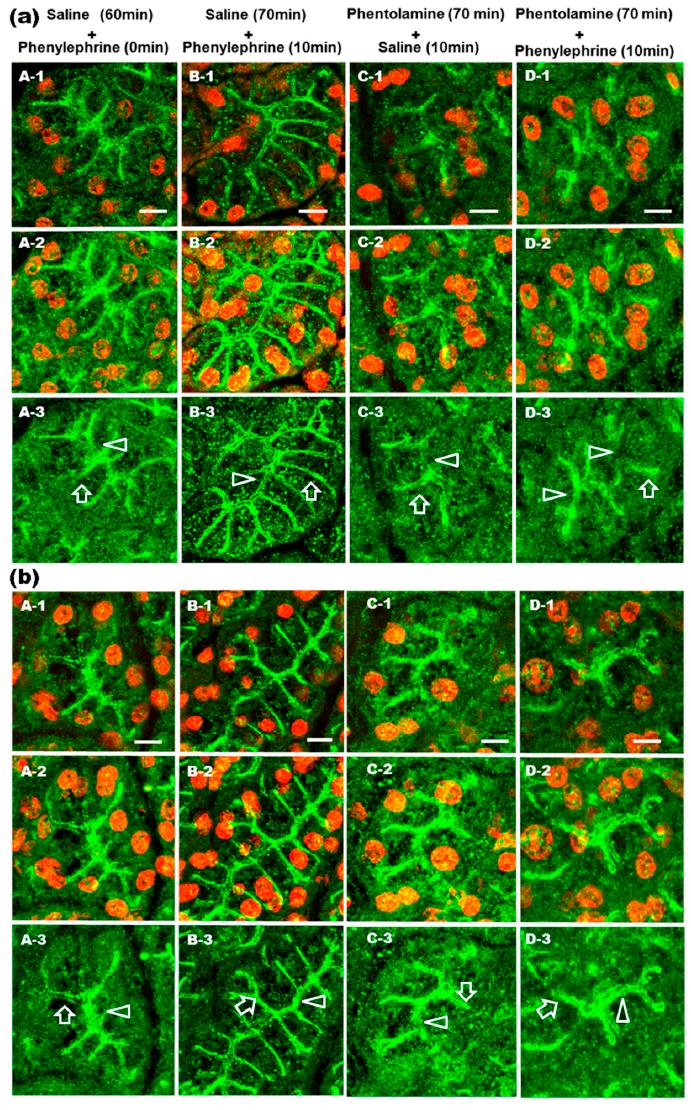
Figure 2. Immunohistochemical analysis of AQP5 and GM1 distributions in rat parotid acinar cells after phenylephrine and phentolamine injection. Rats were intraperitoneally injected with phentolamine (10 mg/kg) ( C and D ) or saline ( A and B ). After 60 min, phenylephrine (0.25 mg/kg) ( B and D ) was intravenously injected. Parotid glands were obtained from rats 0 ( A ) and 10 ( B – D ) min after phenylephrine or saline injection. Alexa-488 was used to visualize AQP5 ( a ) and GM1 ( b ). PI was used to stain nuclei. One section is presented in each single image ( − 1). Sixteen consecutive images produced by a confocal microscope were projected to generate a single image ( − 2). To get clear visualization of AQP5 localization in the acinar cells, the 568 nm laser was turned o ff ( − 3). Arrow heads and arrows indicate APM and LPM, respectively. Scale bars: 10 µm.